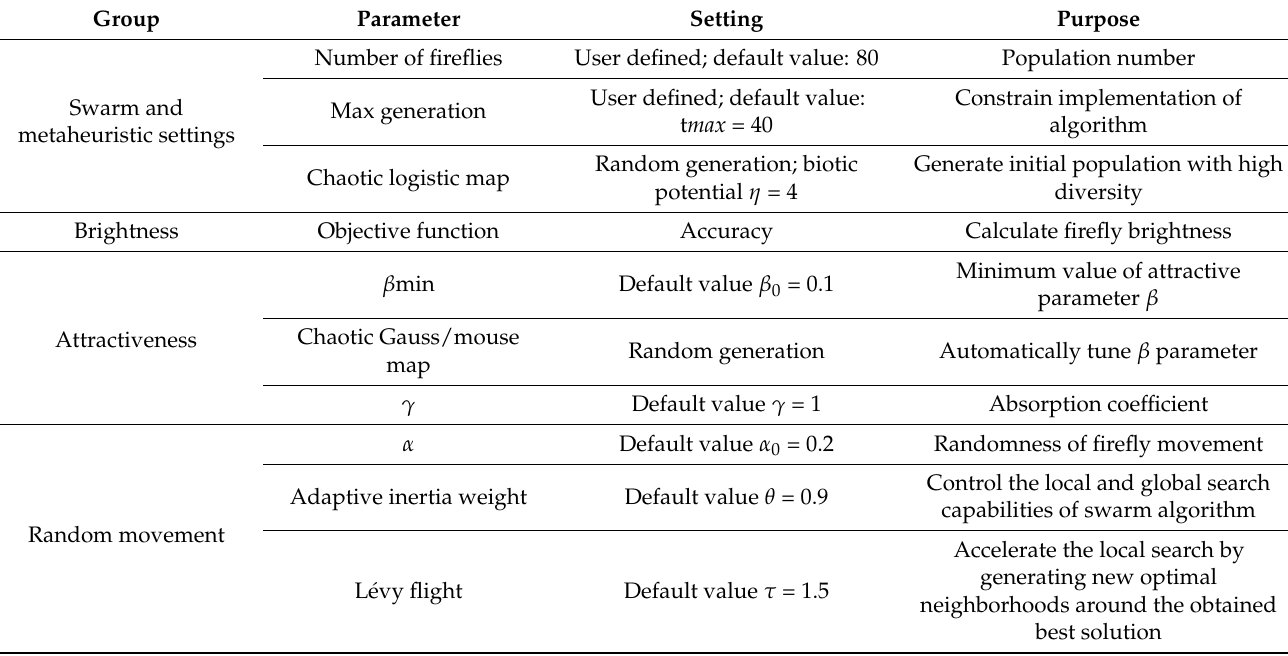
Table 1. Default settings of parameters of enhanced